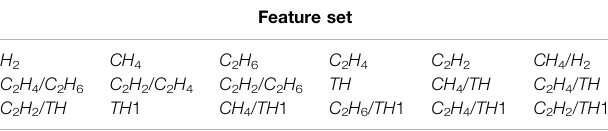
TABLE 1 | The candidate feature set for intelligent fault diagnosis methods. Gas concentrations (ppm) and ratio of gas concentrations in the